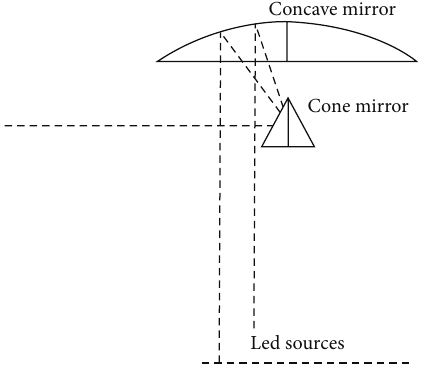
Figure 1: Working principle of the LED-based